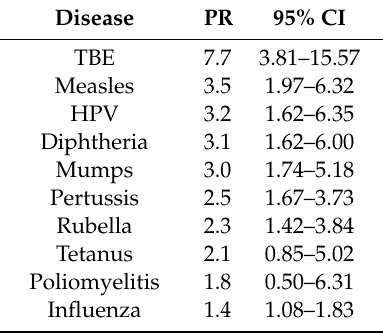
Table 3. Association (prevalence ratio (PR) and 95% confidence interval (95% CI)) between the perception of the severity of disease and intention to vaccinate against the disease.